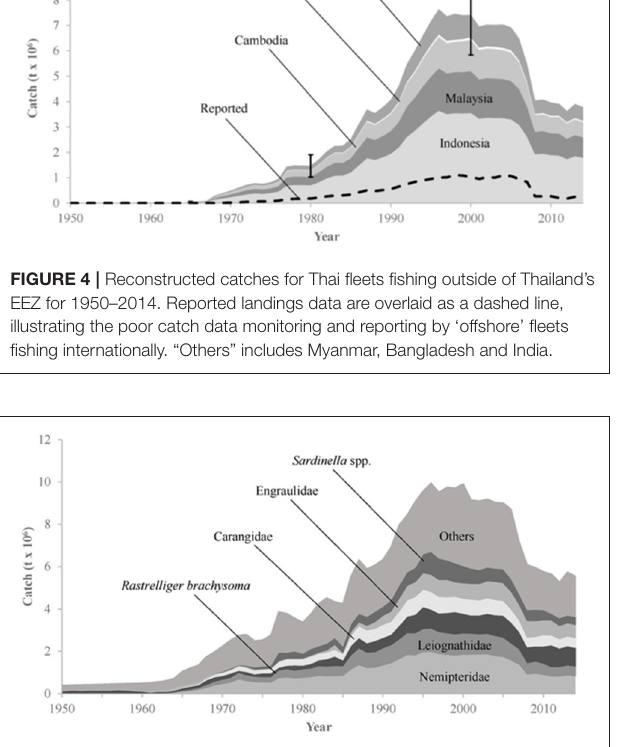
landings respectively, while 13 million tons were discarded over the entire time period.